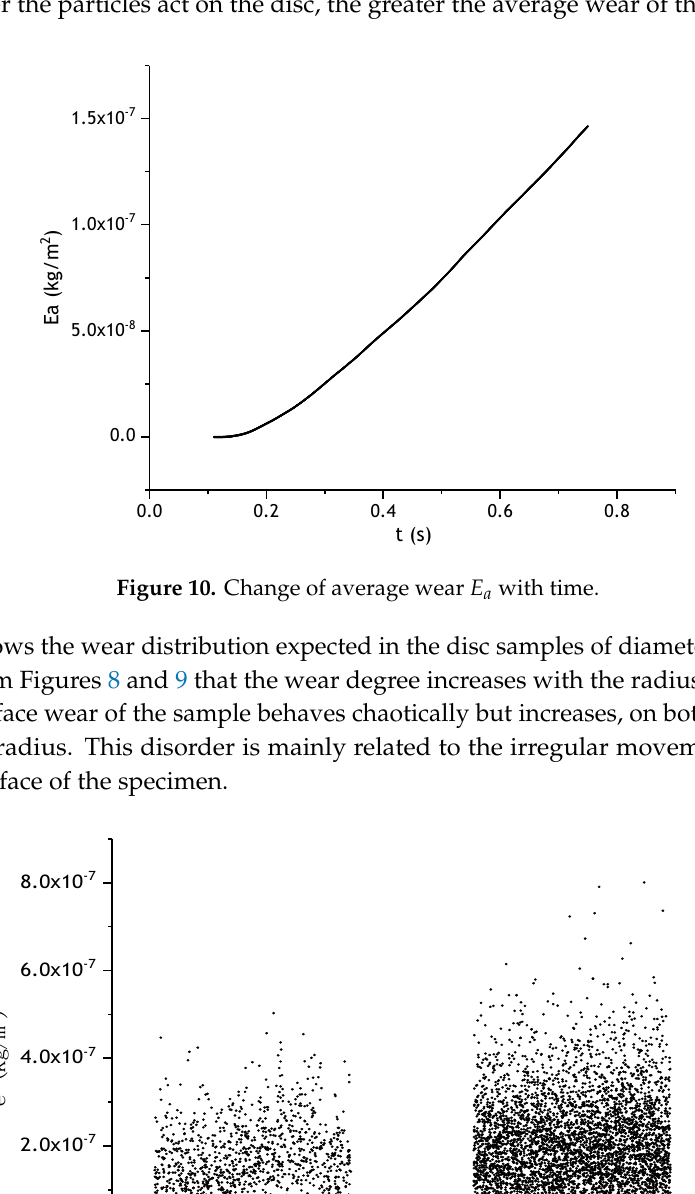
Figure 9. Change of wear E with radius of disc.